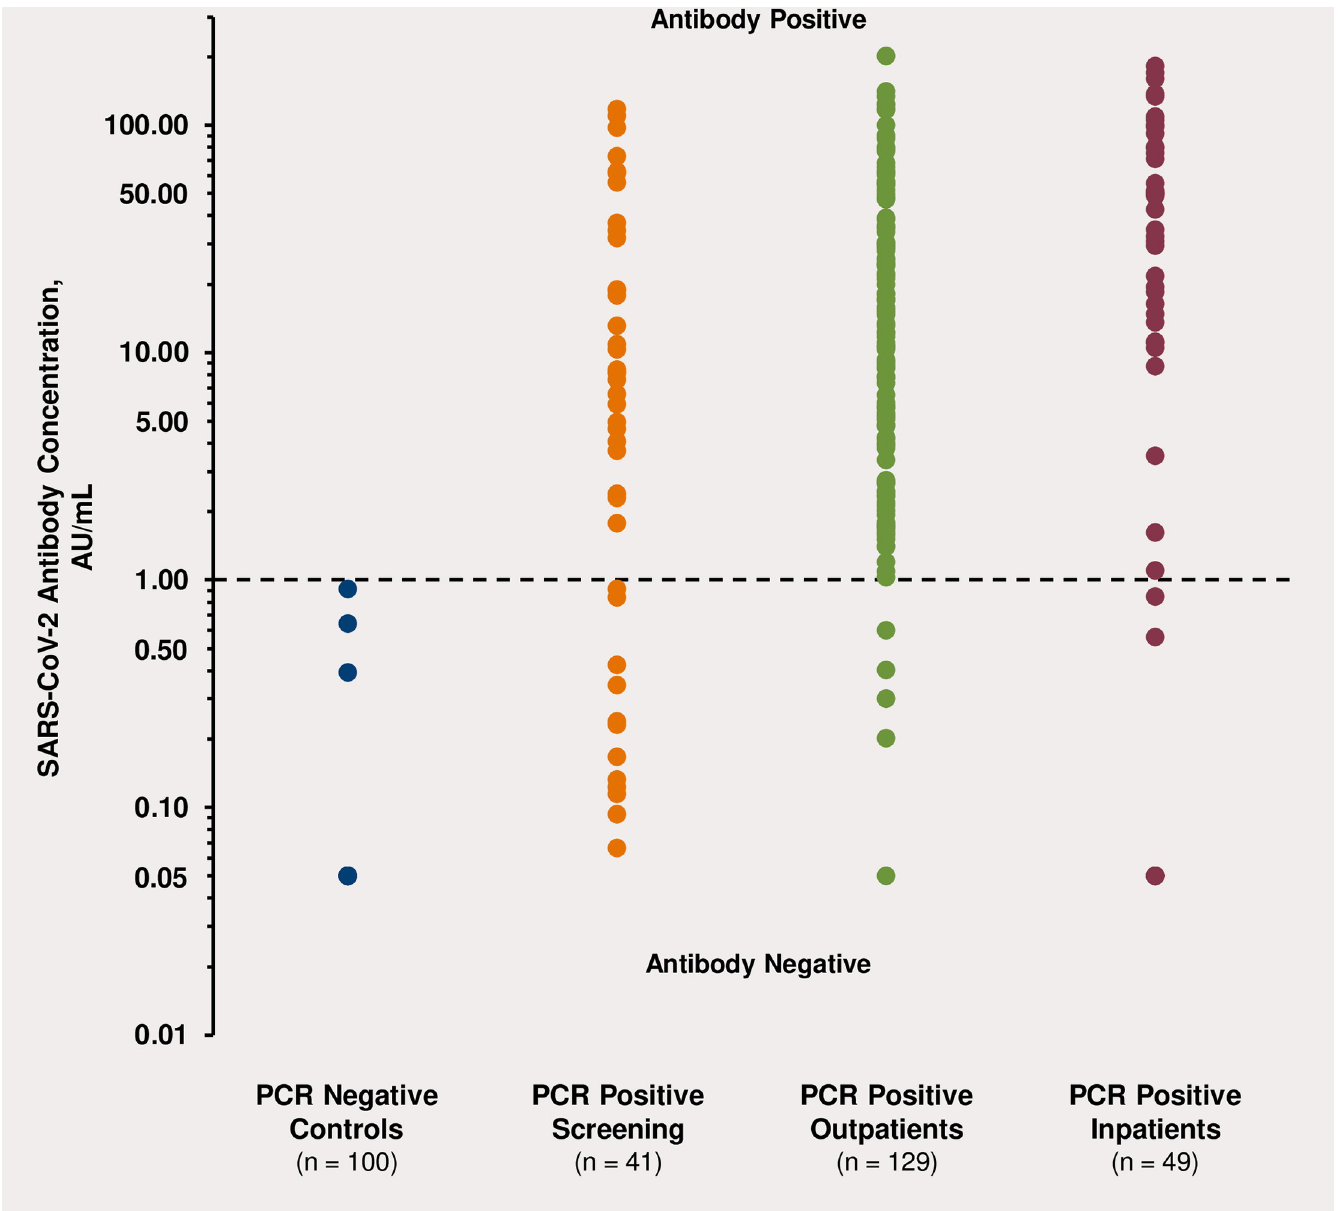
Fig 1. Variability in SARS-CoV-2 IgG antibody response. SARS-CoV-2 antibody response is shown in negative control subjects, for most of whom IgG values were < 0.05 AU/mL and 100% were < 1.0 AU/mL (dark blue circles); meat packing plant employees having antibody screening who were SARS-CoV-2 PCR RNA positive 2 weeks prior to testing (24.4% had IgG values < 1.0 AU/mL) (orange circles); positive outpatients 4–6 weeks after positive SARS-CoV-2 RT-PCR RNA testing (3.9% had IgG values < 1.0 AU/mL) (green circles); and positive SARS-CoV-2 RT-PCR RNA inpatients (6.1% had IgG values < 1.0 AU/mL) (dark red circles). Dotted line indicates negative and positive SARS-CoV-2 IgG levels. IgG, immunoglobulin G; RT-PCR, reverse transcriptase-polymerase chain reaction.